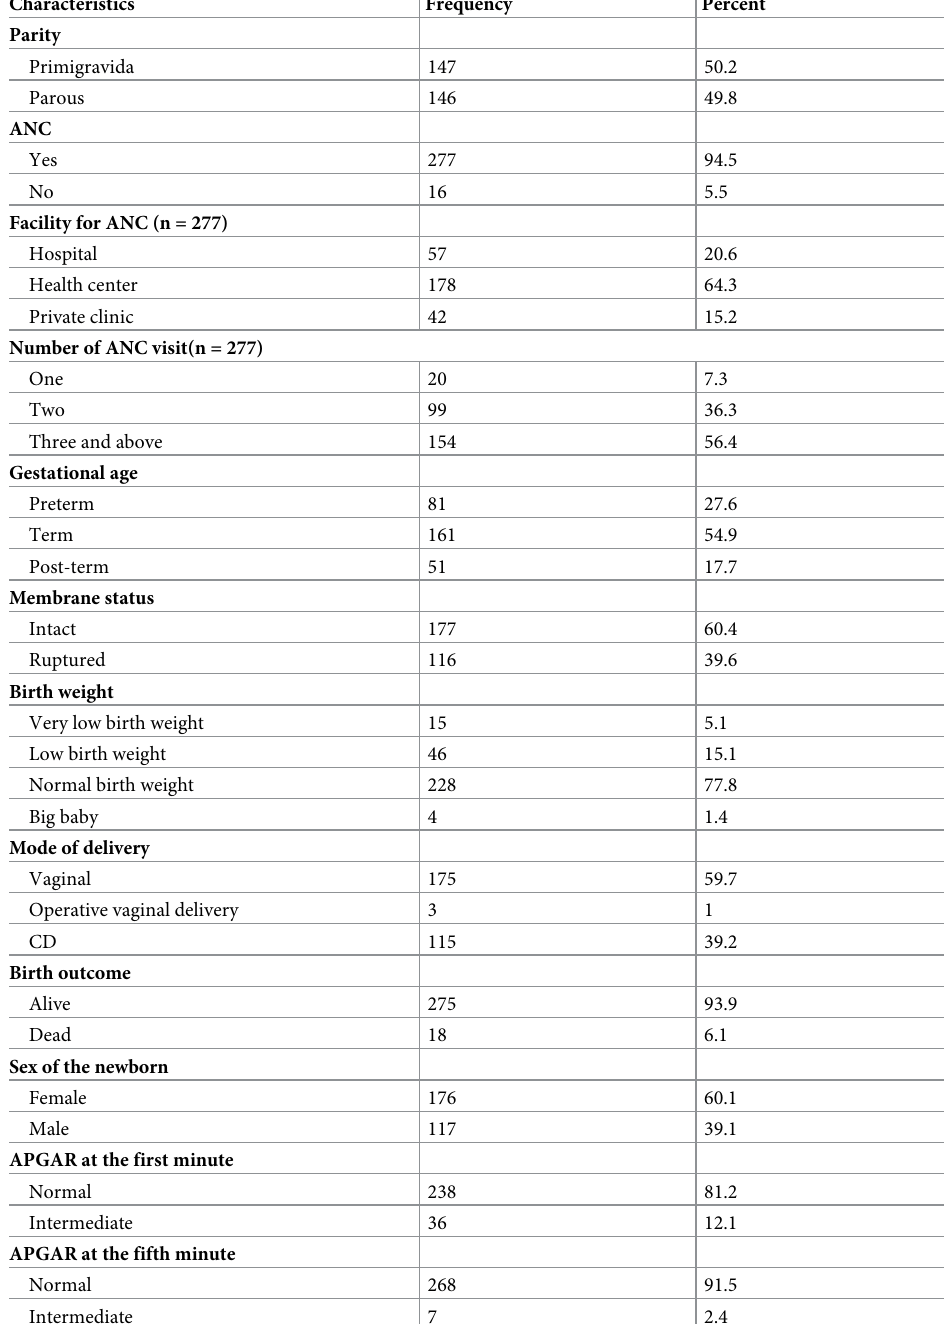
Table 2. Obstetric and fetal characteristics of study participants, in Adama Hospital Medical College, East Shoa, Ethiopia, 2020 (n = 293). Characteristics